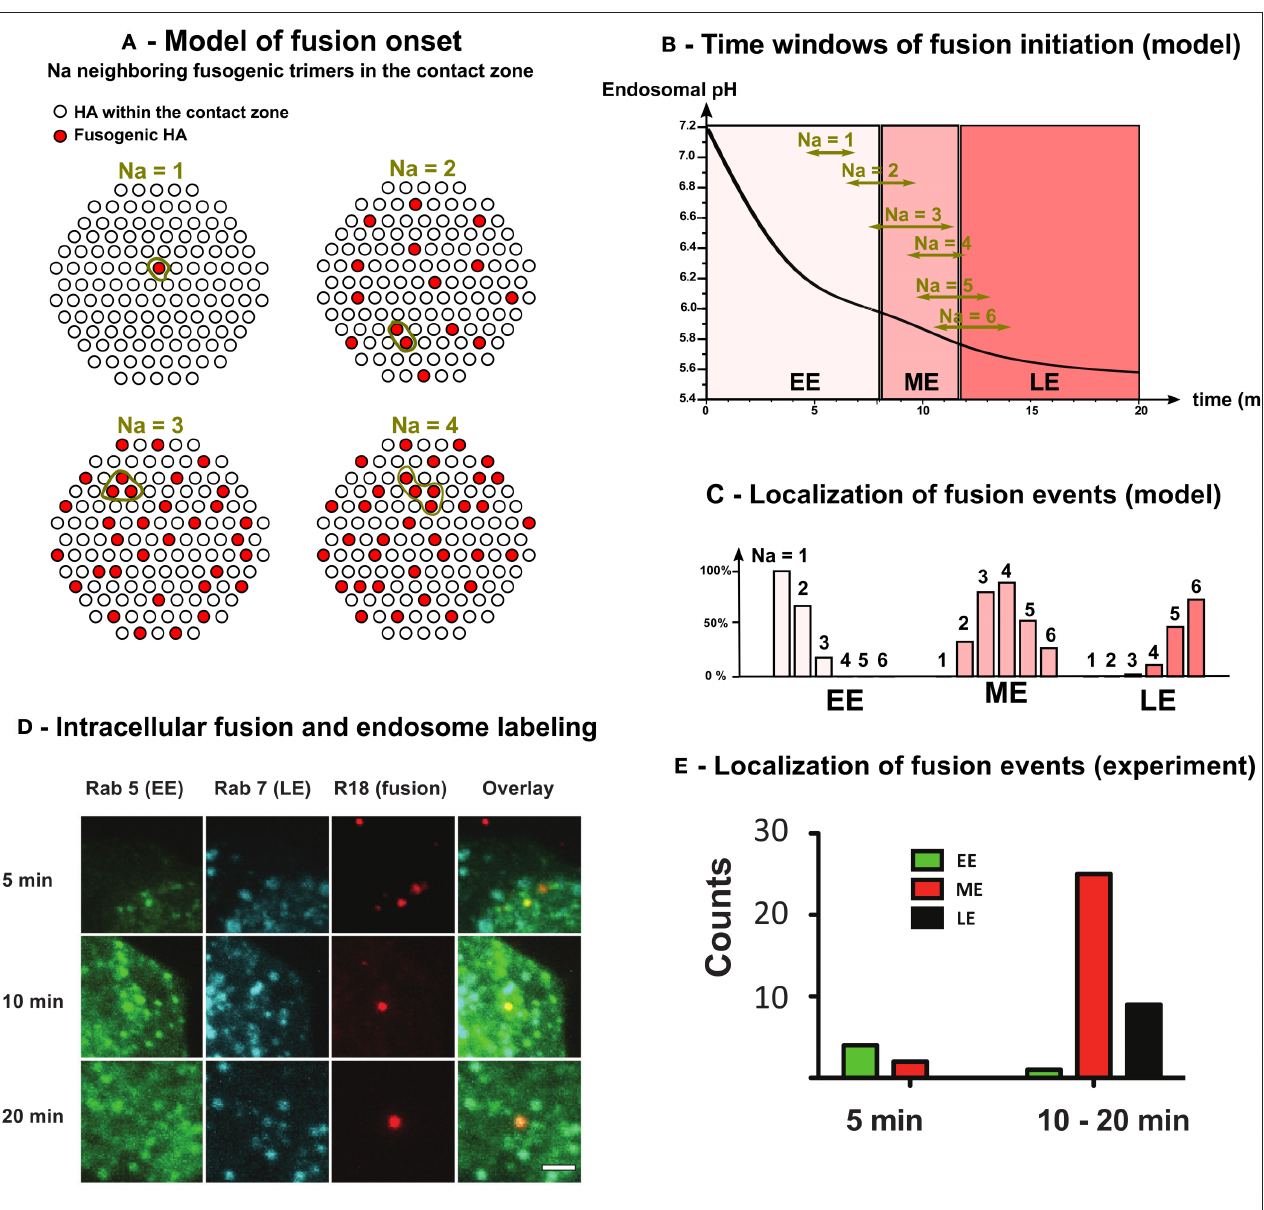
FIGURE 4 | Model and fluorescence experiments of the intracellular onset of virus-endosome fusion. (A) The fusion between virus and endosome membranes is triggered by the conformational change of Na adjacent HAs in the contact zone between virus and endosome ( [17]). (B) Solving Equation (31) we estimated the time window (95 % confidence interval) of intracellular fusion for 1 and endosome maturation kinetics (Equation 7), we estimated the localization (EE, ME, or LE) of fusion onset as function of the number Na of adjacent fusogenic HAs needed for the fusion onset. (D) MDCK cells expressing Rab5-CFP and Rab7-GFP were incubated with R18-labeled Influenza A viruses. Fusion was observed as a strong increase of R18 signal due to de-quenching after dilution. Scale bar categorized regarding their localization in early endosome (EE) (Rab5), ME (Rab5